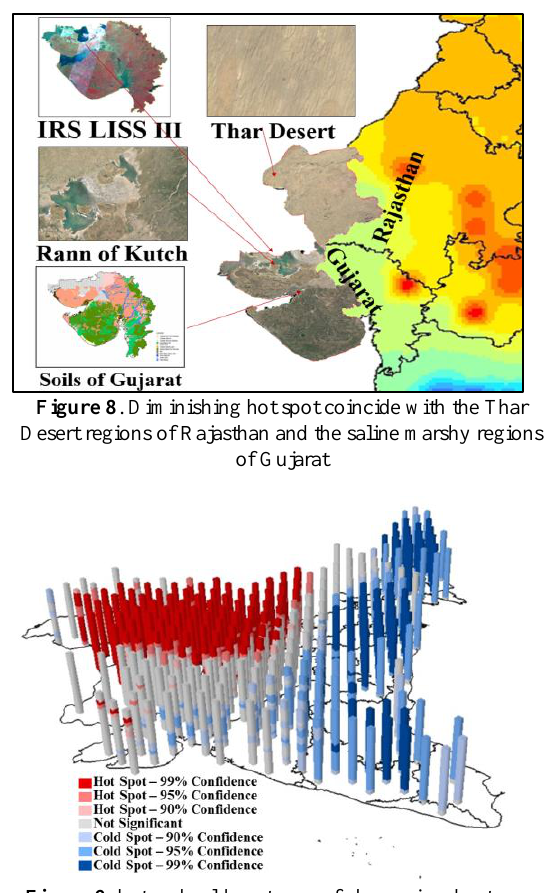
Figure 9 . hot and cold spot map of change in wheat crop area